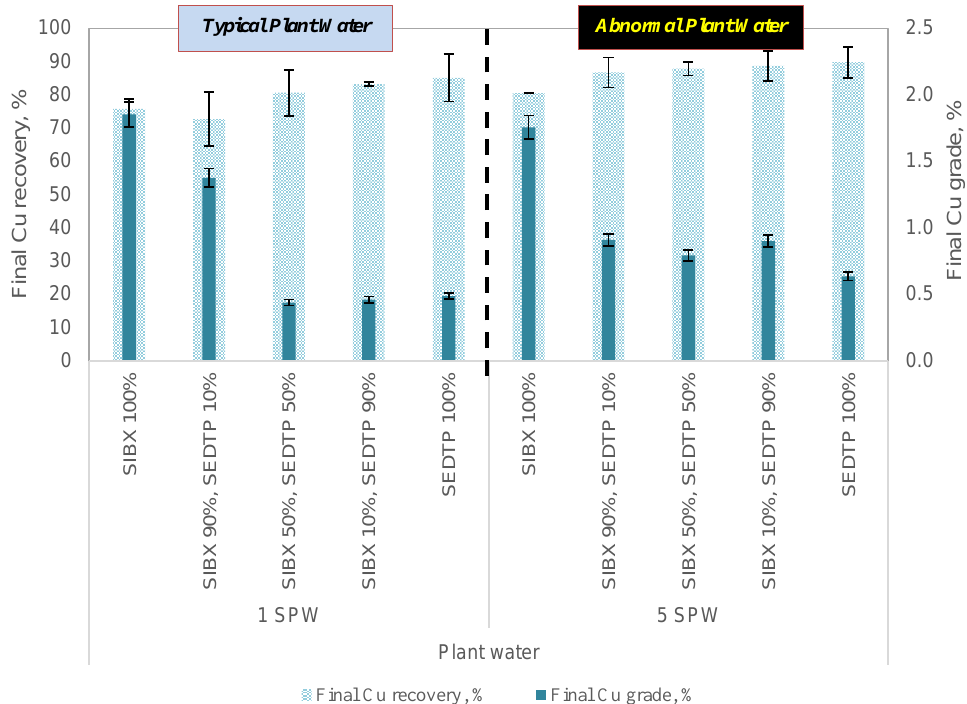
Figure 3. Final copper recoveries and grades for all SIBX / SEDTP mixtures and ionic strengths of process water.